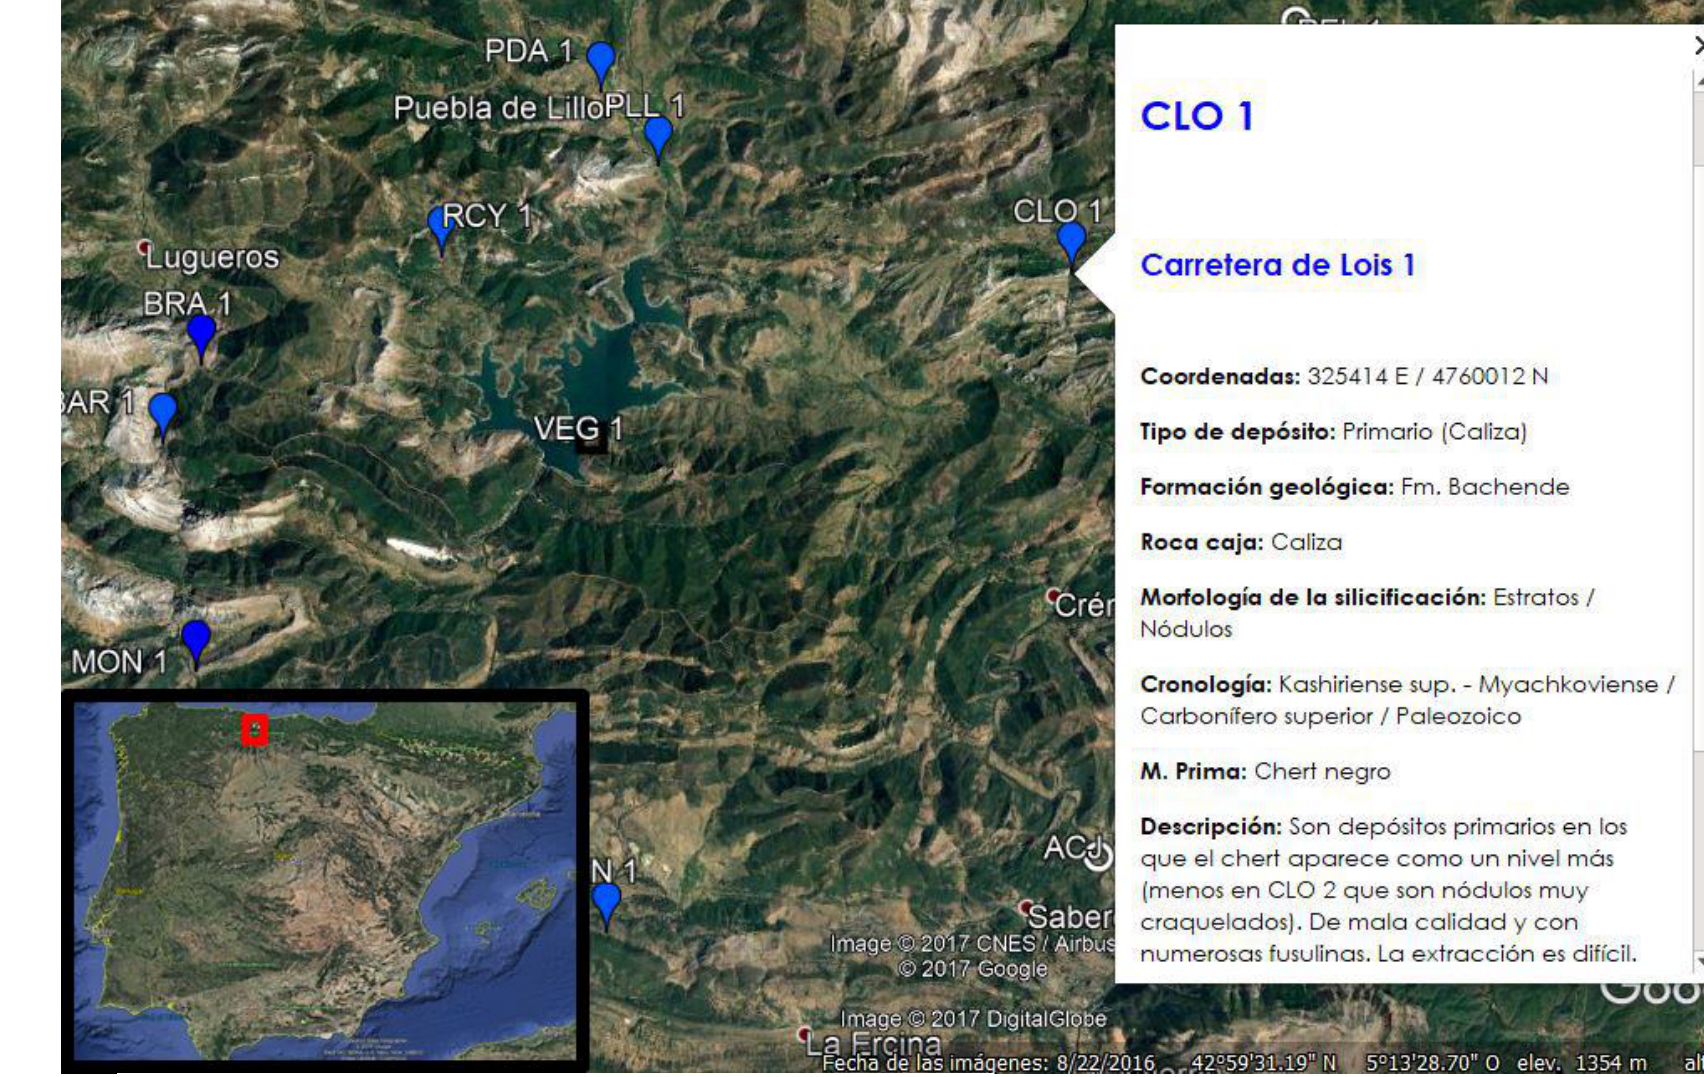
Figure 8: Example of the drop-down information menu that has been developed for each outcrop (Source: Google Journal of Lithic Studies (2018) vol. 5, nr. 2, p. xx-xx